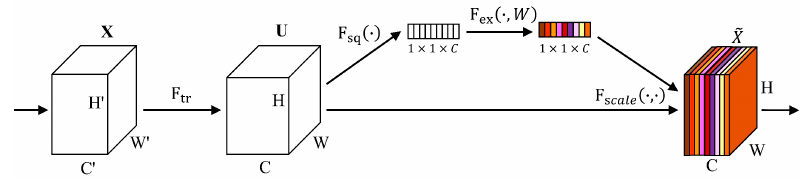
Figure 2. Squeeze-and-excitation operation